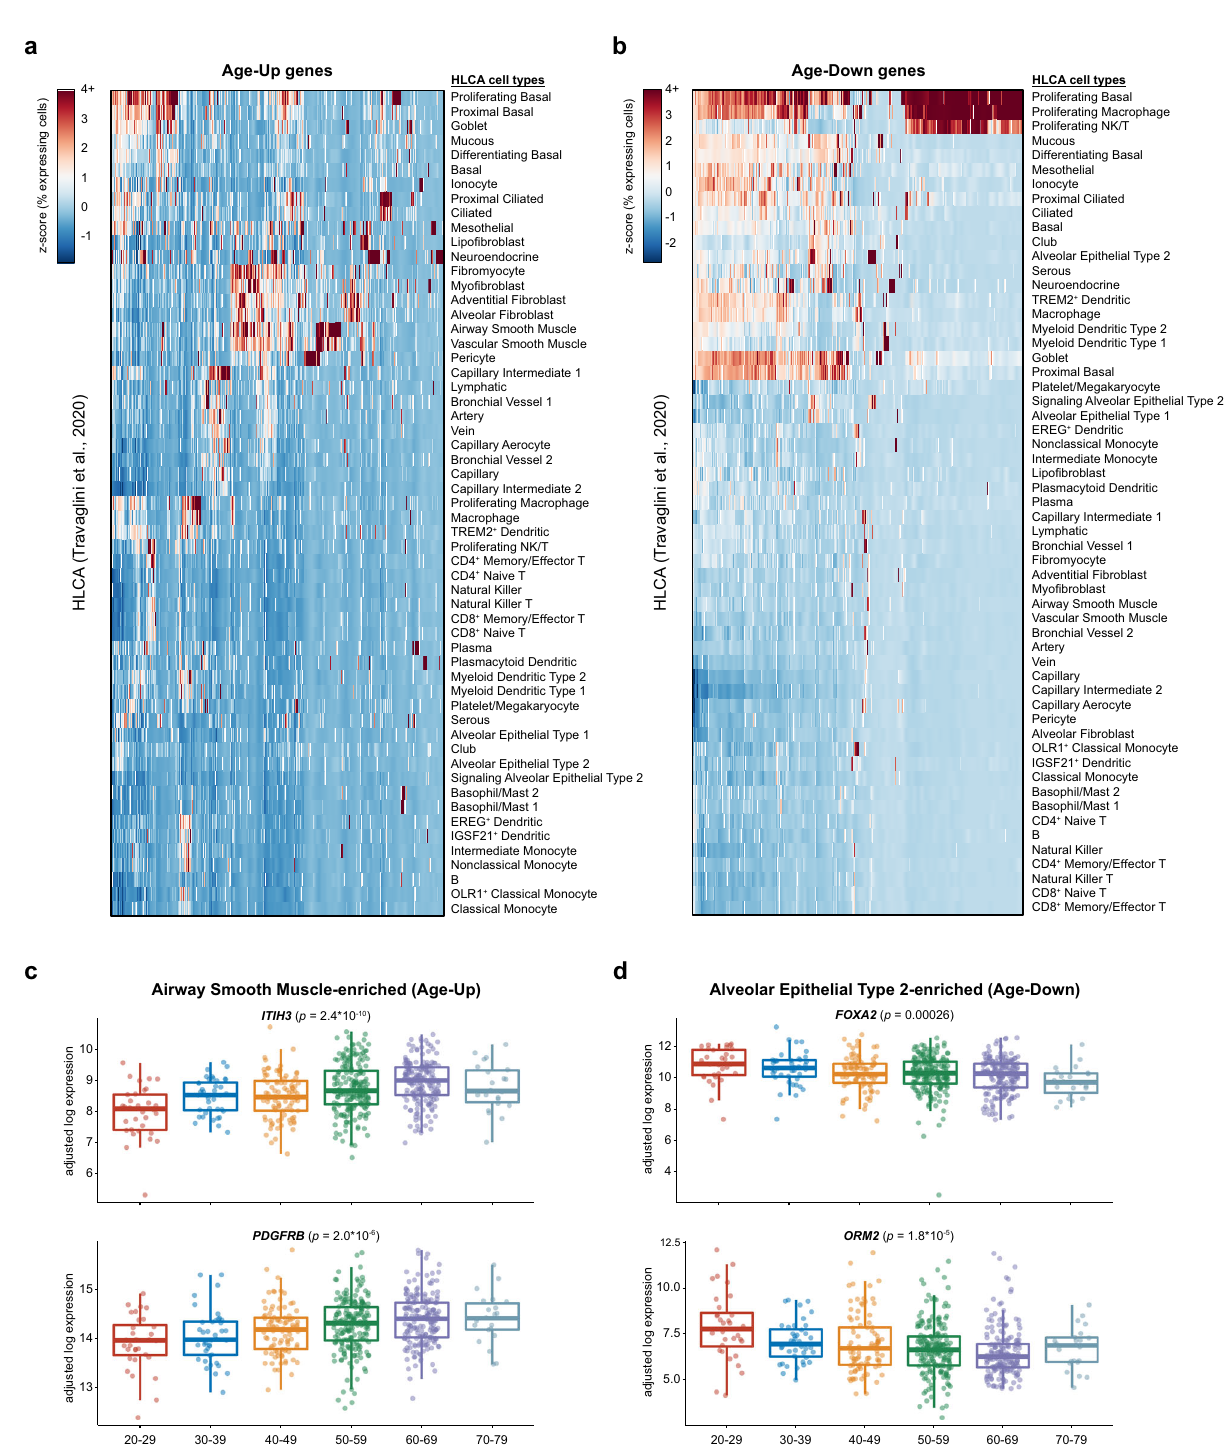
Fig. 2 Lung single-cell transcriptomics pinpoints cell type-speci fi c expression of age-associated genes. a Heatmap showing the percentage of cells expressing each of the Age-Up genes (increasing with age), scaled by gene across the different cell types. Data are from the Human Lung Cell Atlas 44 . b Heatmap showing the percentage of cells expressing each of the Age-Down genes (decreasing with age), scaled by gene across the different cell types. Data are from the Human Lung Cell Atlas 44 . c , d Tukey boxplots (interquartile range (IQR) boxes with 1.5× IQR whiskers) showing the expression of ITIH3 and PDGFRB ( c ), or FOXA2 and ORM2 ( d ), across different age groups ( n = 561 samples). Data are shown as log-transformed expression values, adjusted for sex, smoking status, and Hardy scale. Statistical signi fi cance of age-associated variation was assessed by two-sided Kruskal – Wallis test on the adjusted expression